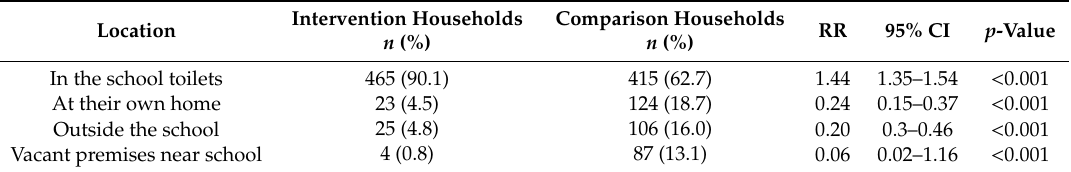
Table 5. Self-report of where students usually defecate or urinate during school hours.